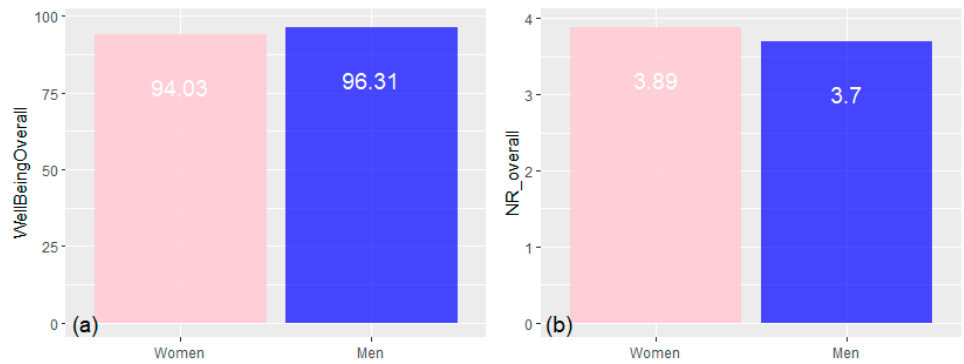
Figure 1. The comparison of average overall components for Psychological Well-being ( a ) and Nature Relatedness Scale ( b ).